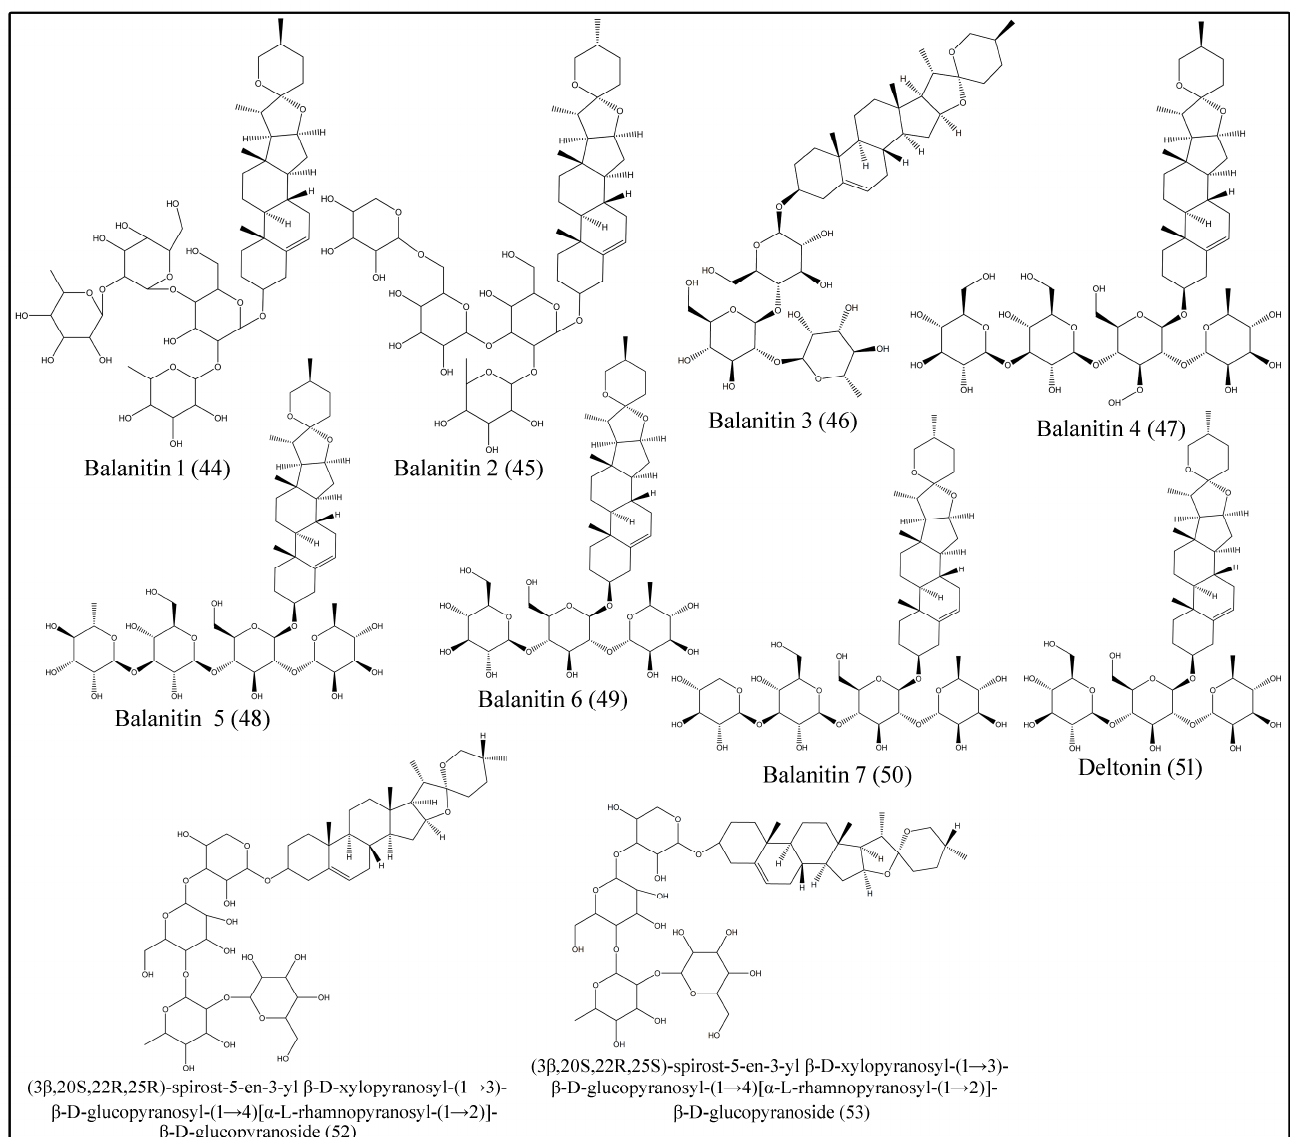
Figure 5. Structures of spirostanol saponins isolated from desert